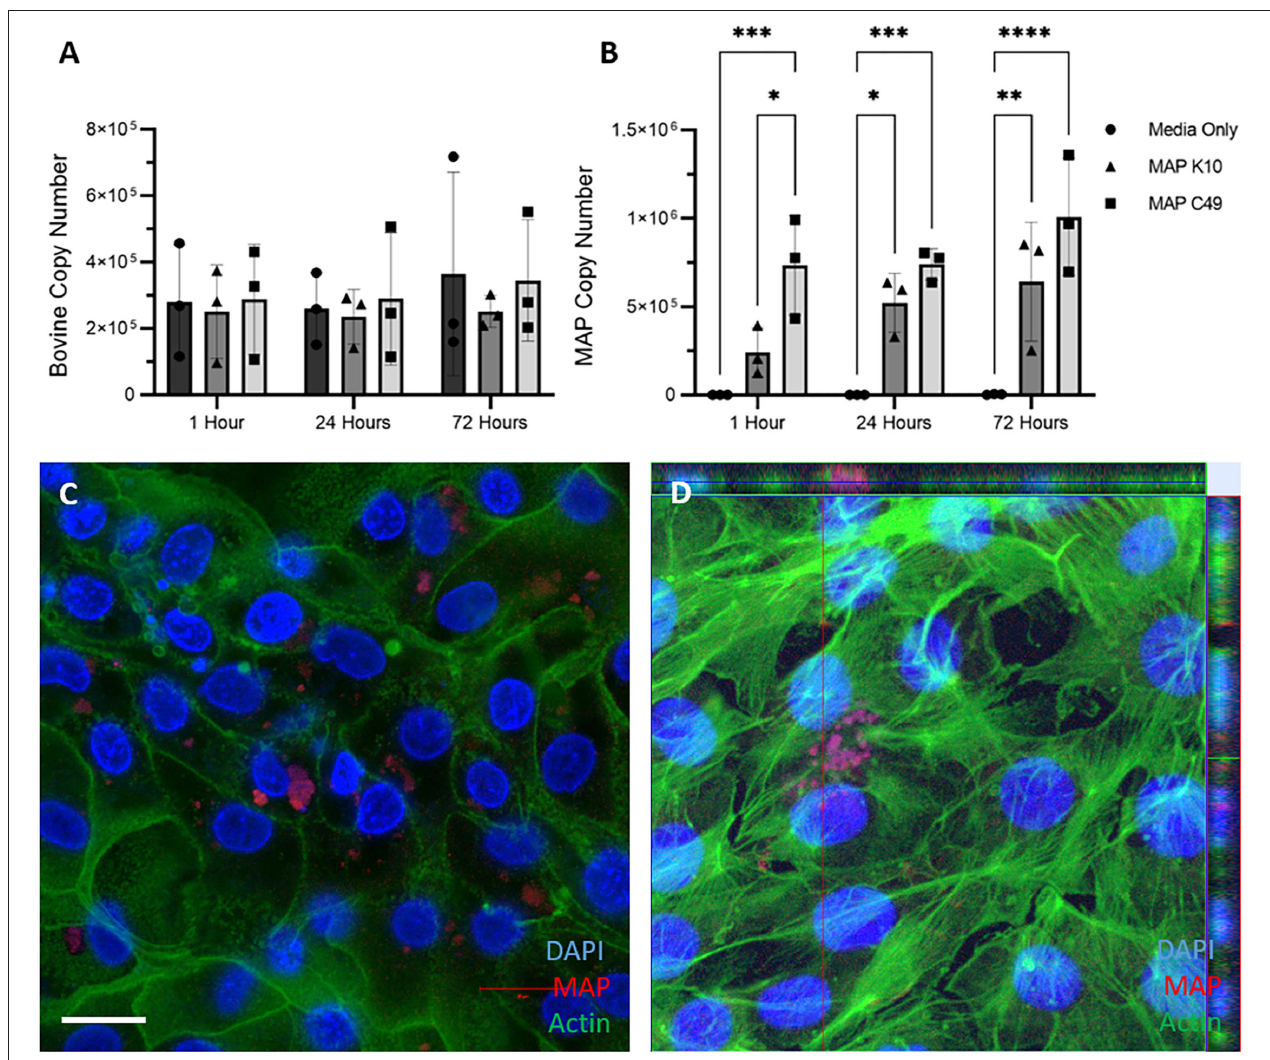
FIGURE 6 | Infection of 2D monolayers with 2 different strains of MAP. Monolayers were infected with an MOI of 10 in 3 independent experiments. The bovine (A) and bacterial (B) cell number was quantified using qPCR for the spastin gene and F57 sequence element respectively via qPCR (data presented as mean ± SD). Statistical analysis performed using 2-way ANOVA followed by a post hoc Tukey’s test. P < 0.05 = *; P < 0.01 = **; P < 0.001 = ***; P < 0.0001 = ****. (C,D) Immunofluorescence staining of monolayers imaged 24 hours post infection. Infected monolayers were fixed and stained for nuclei (DAPI, blue), F-actin (Phalloidin, green) and MAP (anti-MAP, red). Cells were infected with MAP K10 (C) and as a cross section from Z-stack images infected with MAP C49 (D) . Scale bar = 10 µ